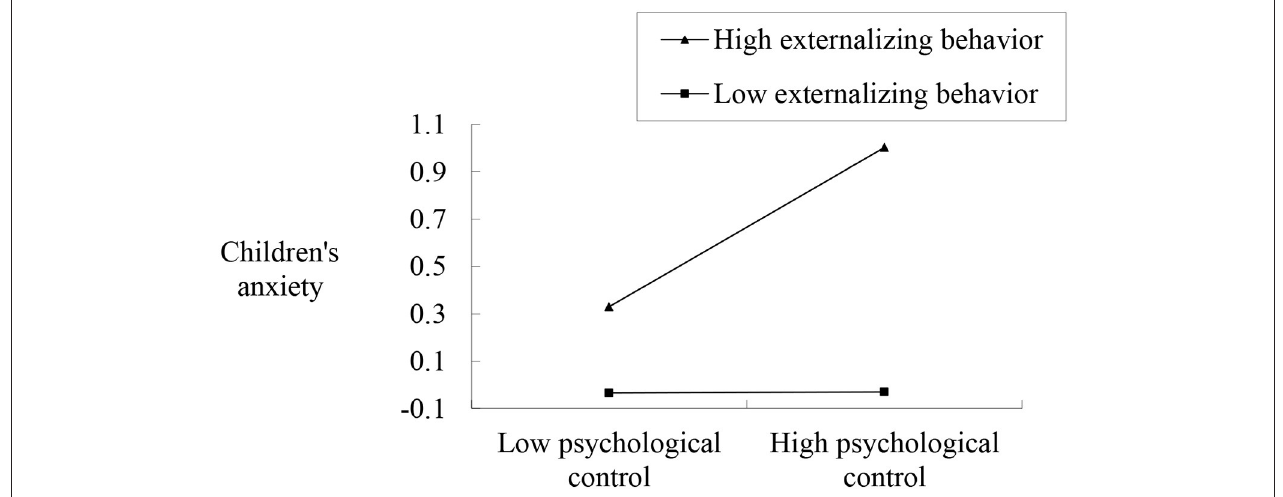
FIGURE 1 | Interaction between maternal psychological control and externalizing problem behavior in predicting accompanied children’s